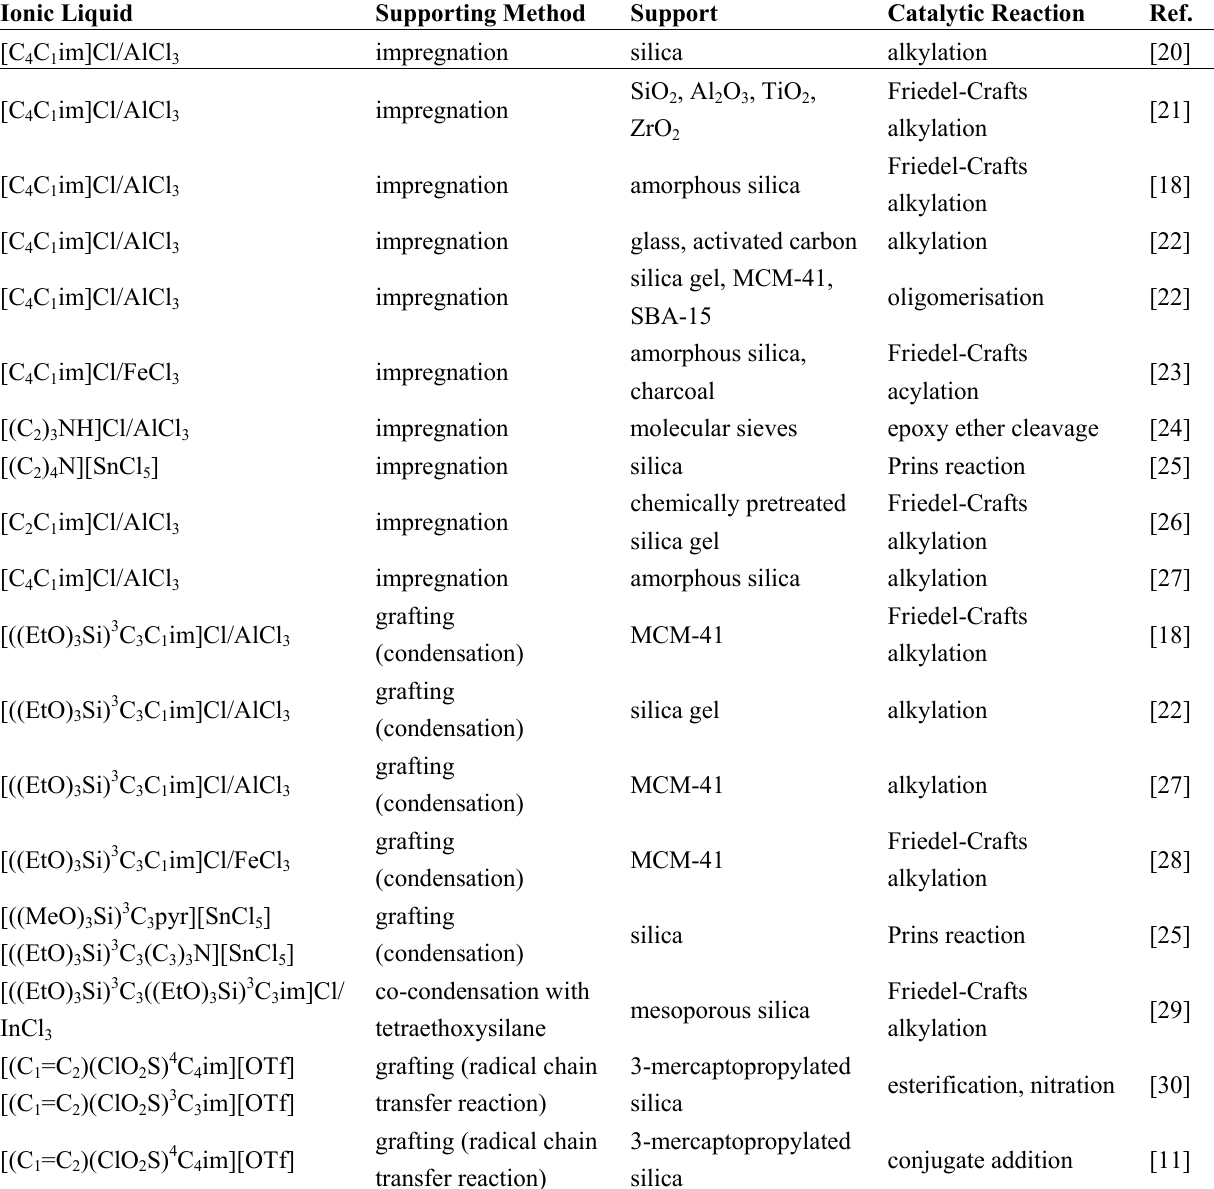
Table 1. Preparation of supported Lewis acidic ILs and their application in catalytic reactions. Ionic Liquid Supporting